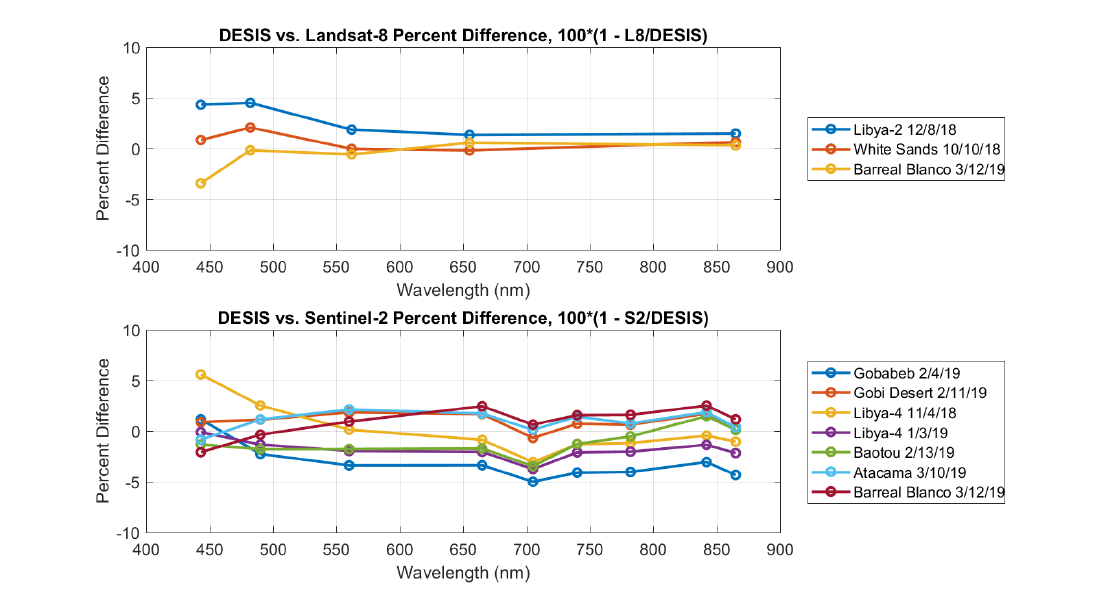
Figure 15. Differences (%) between DESIS and Landsat-8 ( top ) and Sentinel-2 ( bottom ) TOA reflectance for all sites.